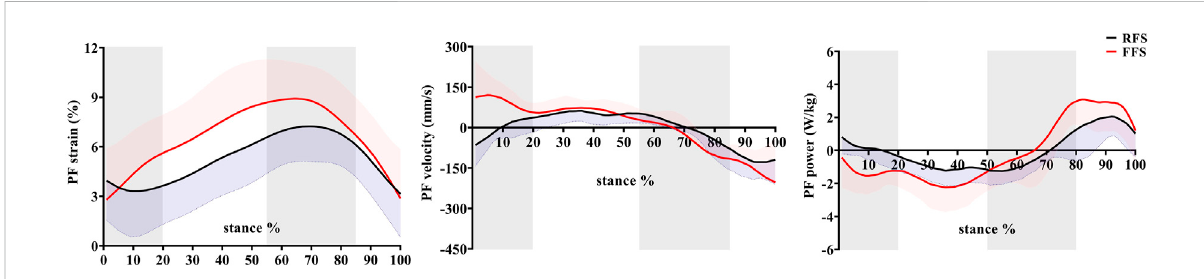
FIGURE 4 Effects of foot strike patterns on strain, velocity, and power of the plantar fascia during the stance phase of running. Note: RFS, rearfoot strike pattern and FFS, forefoot strike